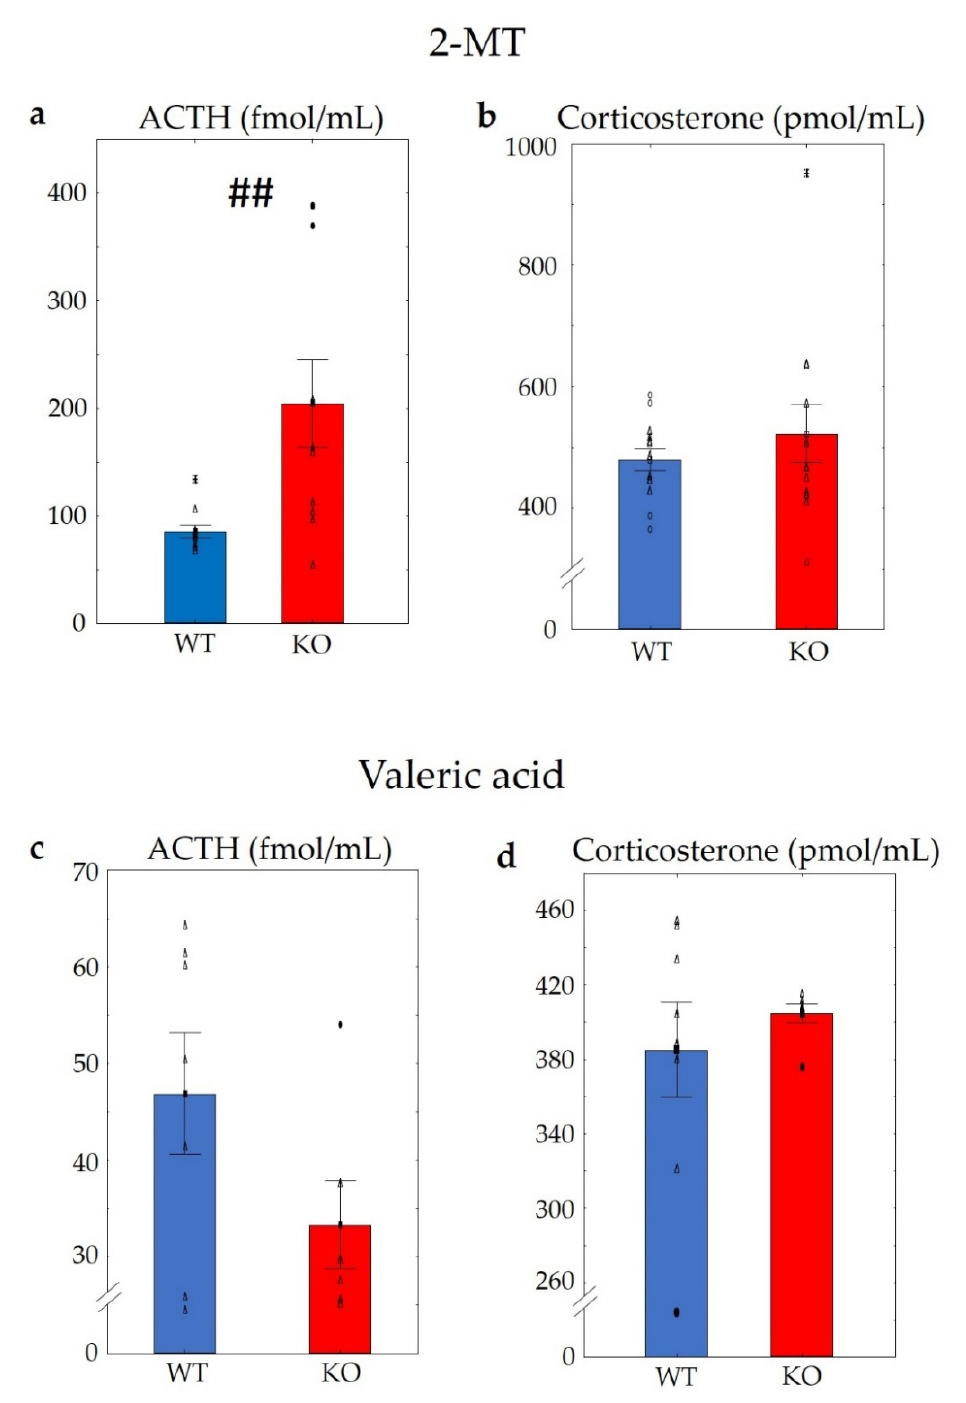
Figure 6. Serum adrenocorticotropin (ACTH) and corticosterone levels of WT and KO mice after using 2-MT or valeric acid. Applying 2-MT, KO mice showed significantly higher ACTH levels than WTs ( a ), without significant differences in the corticosterone levels ( b ). Using valeric acid, no differences in either ACTH ( c ) or in corticosterone levels ( d ) were detectable. The symbol # shows a significant difference between the two genotypes, in cases with ## p < 0.01. n = 10 in both (WT and KO) groups. Blank triangles represent individual values while dark spots show outliers (characterized by a higher or lower value than mean ± 2 standard deviation (SD)).